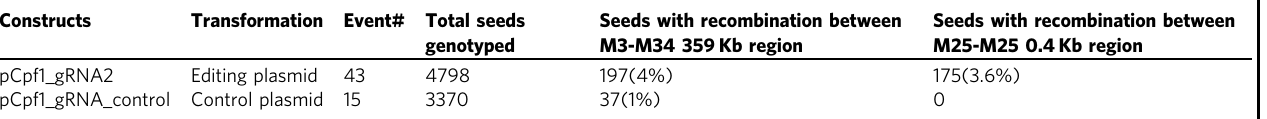
Table 3 Result of the genotyping analysis and identi fi cation of the BC1-F1 seeds with chromosomal recombination at the gRNA2 target